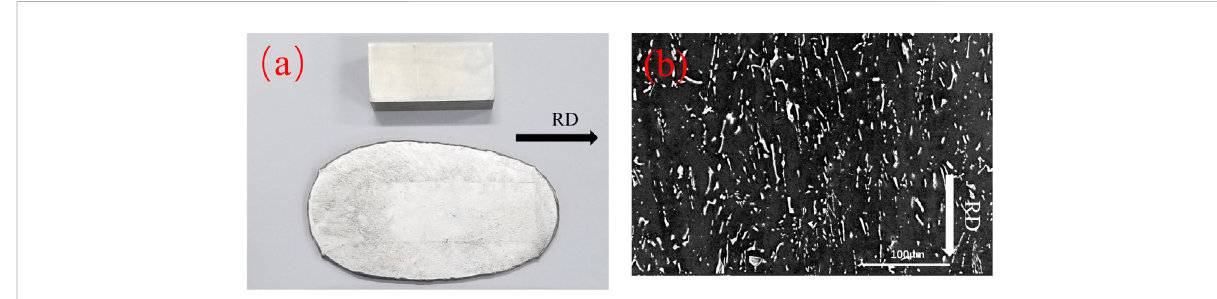
FIGURE 2 Macro and Microstructure of LT146-LSR sample. (A) The macro-optical photograph. (B) SEM micrograph.